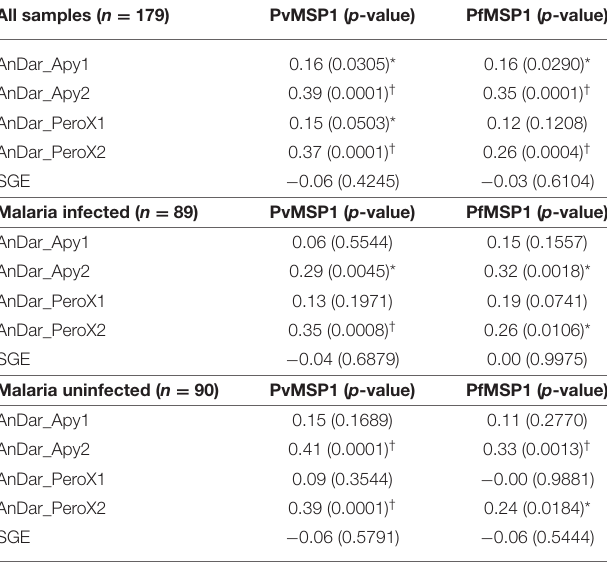
TABLE 4 | Correlation analysis between IgG antibodies against An. darlingi salivary antigens and IgG antibodies against P. falciparum , P. vivax showing samples grouped by infection